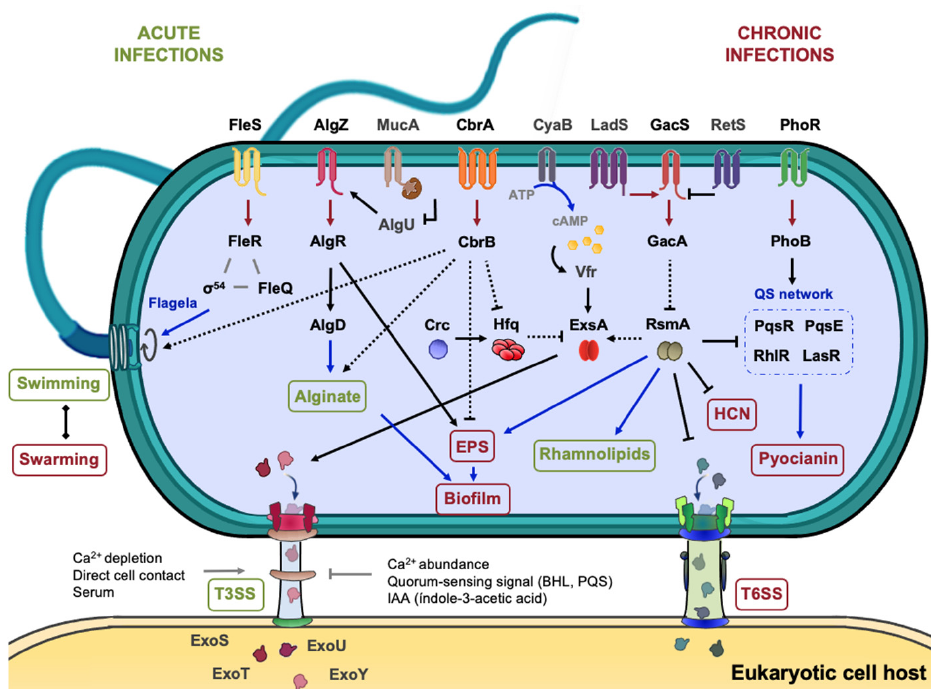
Figure 6. Interaction of multiple pathways involved in mediating P. aeruginosa virulence. FleS, AlgZ, CbrA, GacS and PhoR sensor kinases activate, under induction conditions, their cognate RRs, FleR, AlgR, CbrB, GacA and PhoB, respectively, triggering the activation of acute (boxed in green) or chronic (boxed in burgundy) phenotypes. Biogenesis of pyocyanin is tightly regulated by GacSA-RsmA as well as by the quorum-sensing network. The QS network involves the participation of RRs such as PqsR, PqsE, RhlR and LasR, which are downregulated by RsmA and upregulated by the TCS PhoR/B. Flagellum biogenesis depends on the induction of the TCS FleS/R, where FleR acts as RR together with FleQ. Binding of both proteins to σ N -dependent promoters activates flagellum formation in sequential cascades. The antagonistic effect of Hfq and RsmA on the master regulator of the T3SS, ExsA, is also shown: Vfr promotes ExsA expression in a cAMP-dependent reaction. Red, blue and black arrows indicate phosphotransfer reactions, induction/formation and activation/repression regulation, respectively, with dotted lines indicating an indirect regulation. EPS: exopolyssacharides; HCN: hydrogen cyanide; T3SS: type-3 secretion system; T6SS: type-6 secretion system; BHL: N-butyryl homoserine lactone; PQS: Pseudomonas quinolone signal.